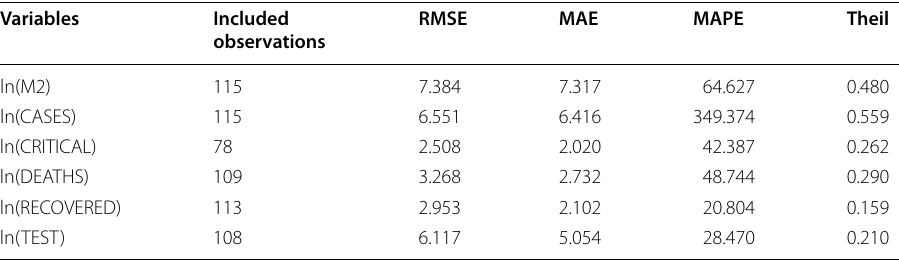
Table 6 Forecast evaluation